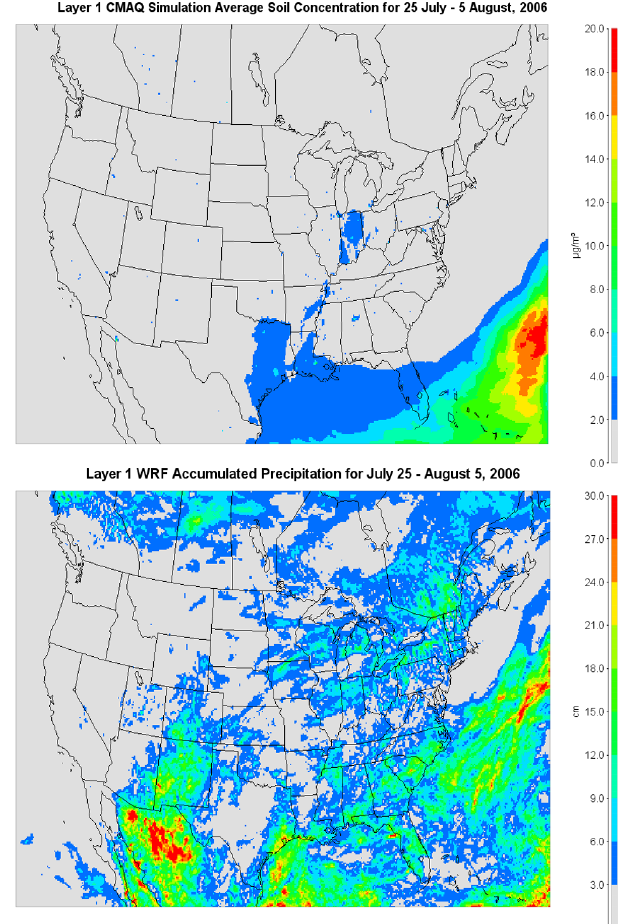
Fig. 7. Layer 1 CMAQ average soil concentration (top; µgm − 3 ) and WRF accumulated total precipitation (bottom; cm) for 25 July– 5 August